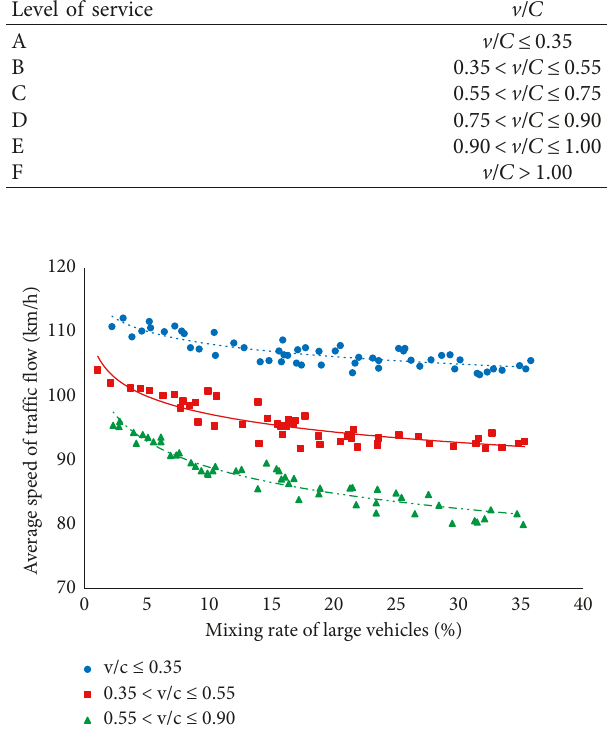
Figure 4: Relationship between the mixing rate of large vehicles and average speed of traffic flow.